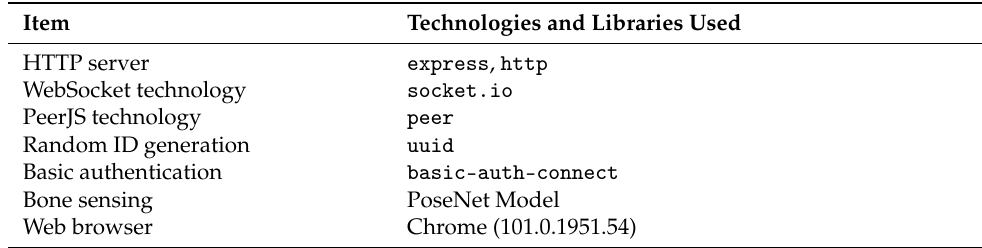
Table 2. Technologies used in the implementation of the proposed system.